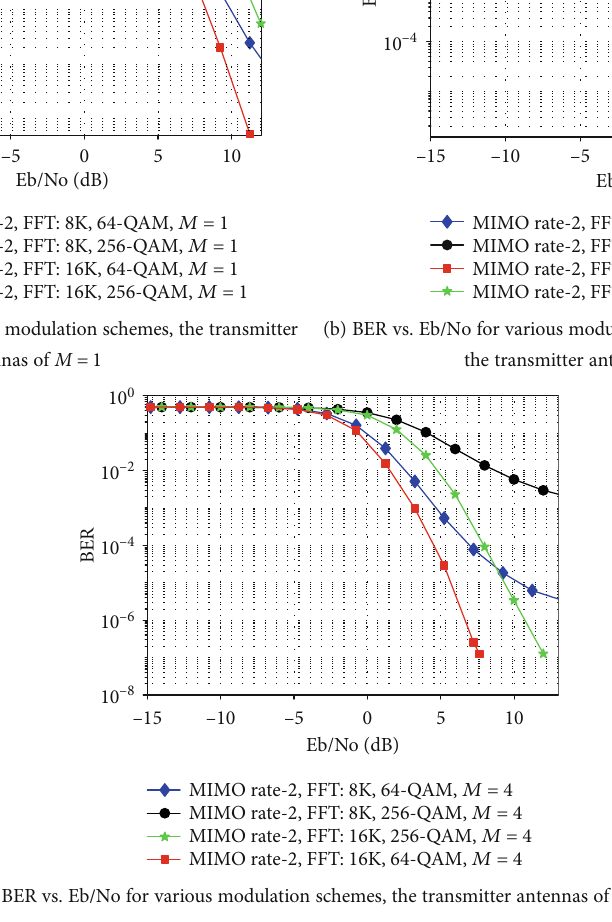
Figure 4: The BER performance against Eb/No for MIMO rate-2 using the modulation schemes of 64-QAM and 256-QAM with the FFT size of 8 K and 16 K for various numbers of antenna element M at the analog